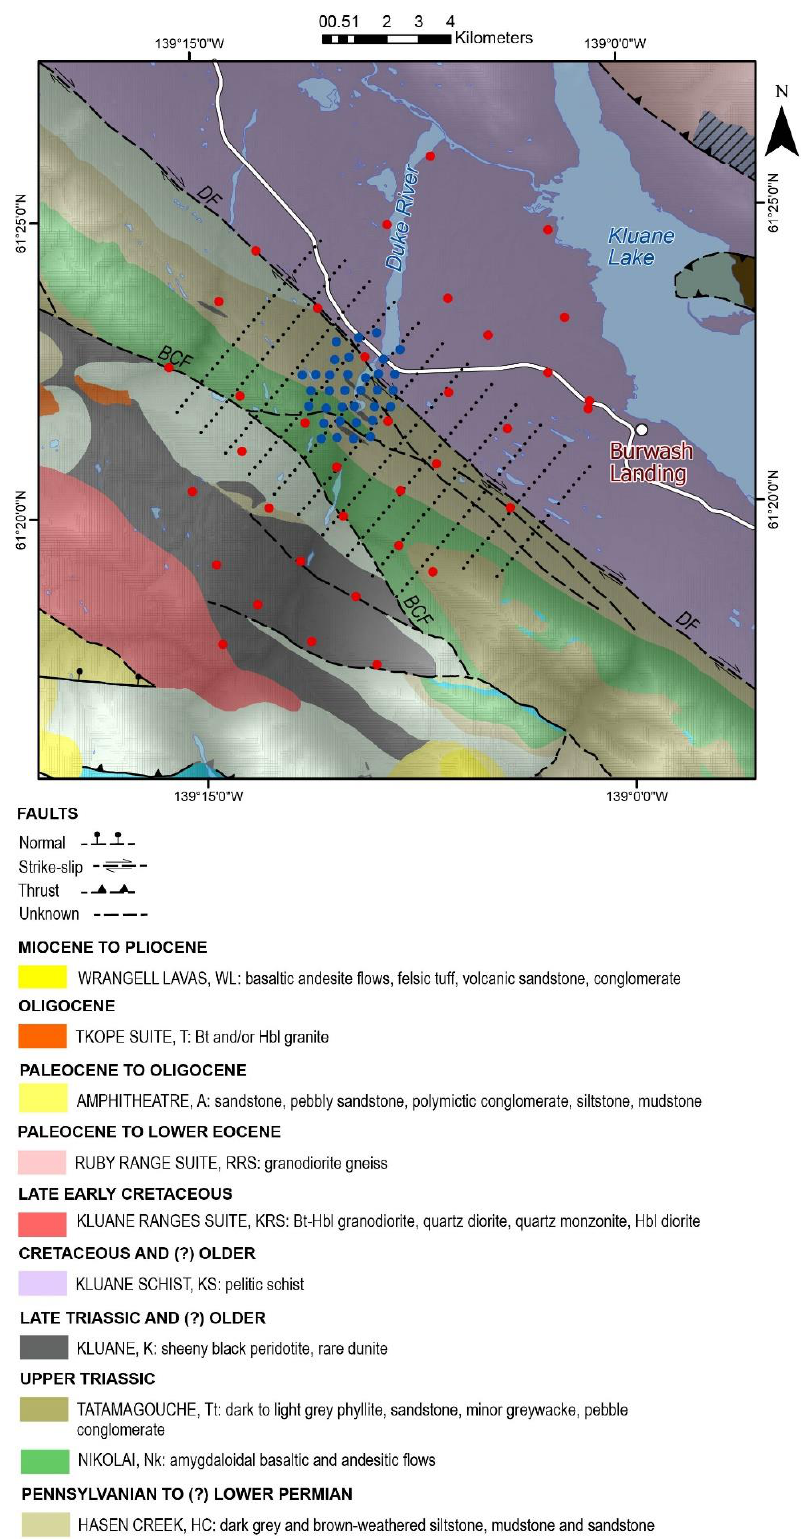
Figure 2. Geological map of the Burwash Landing area (adapted with permission from Ref. [34]. © 2022, Government of Yukon). Faults plotted by black dashed lines. Locations of stations plotted as: MT = red circles; AMT = blue circles; and ELF-EM = black dots. Only geological units discussed in the text are shown in the legend. DF = Denali fault; BCF = Bock’s Creek fault.